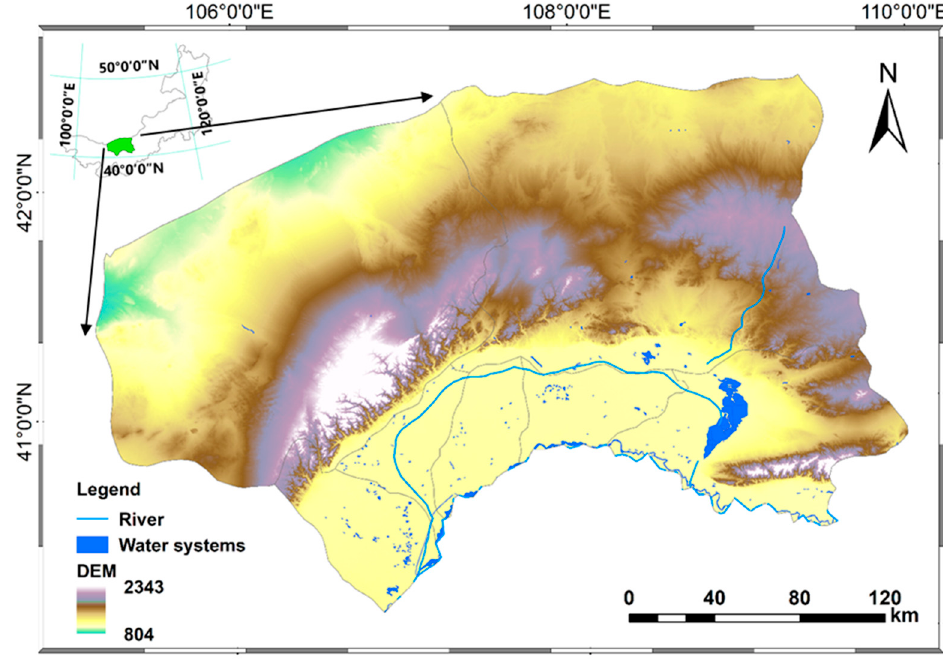
Figure 2. The study